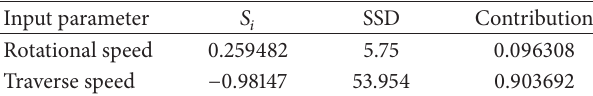
Table 3: Sensitivity analysis for tensile shear force.